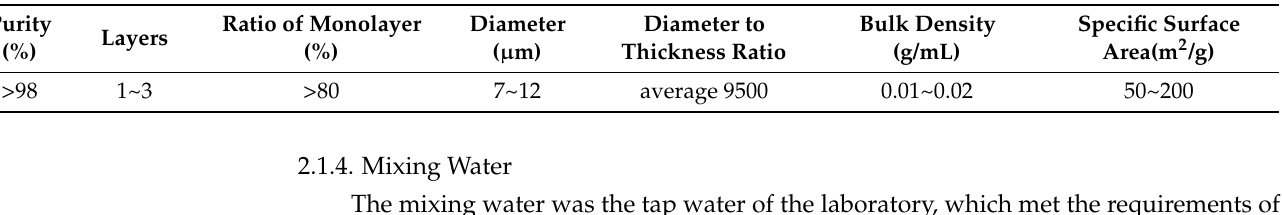
Table 5. Mix proportions of graphene-based cement composites.